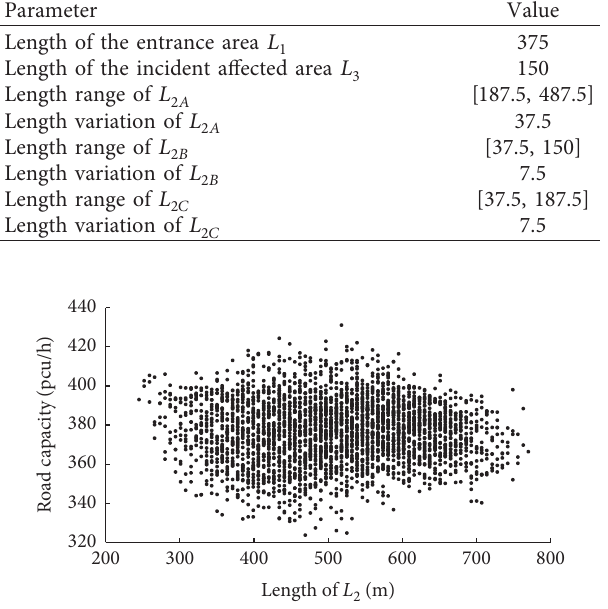
Figure 5: Relationship between road capacity and a portion of road capacity (pch/h). section L 2 Table 3: Detailed proportion of accelerate zone, decelerate zone, and forced zone to the early-warning area.